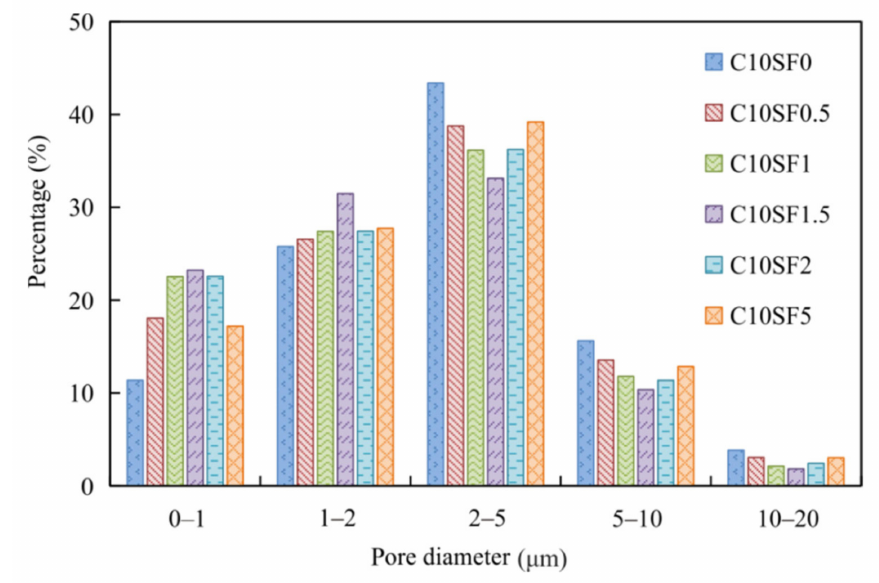
Figure 6. Pore distribution of cement stabilized soil with different SF contents (at 28